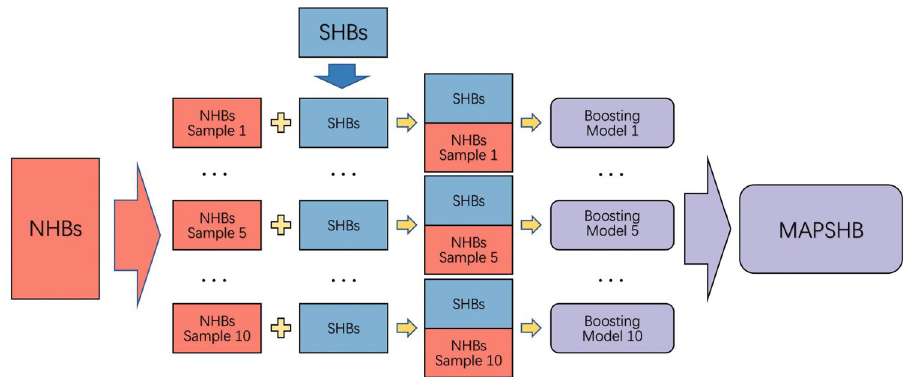
Figure 1. Workflow for the development of the MAPSHB model. In the first step, we randomly sample the NHBs in the training dataset and create 10 subsets that contain 6181 NHBs. In the second step, we form 10 balanced datasets by combining each subset of NHBs with all the SHBs. Next, we develop a boosting model from each of the 10 balanced training set and obtain the final MAPSHB model from their